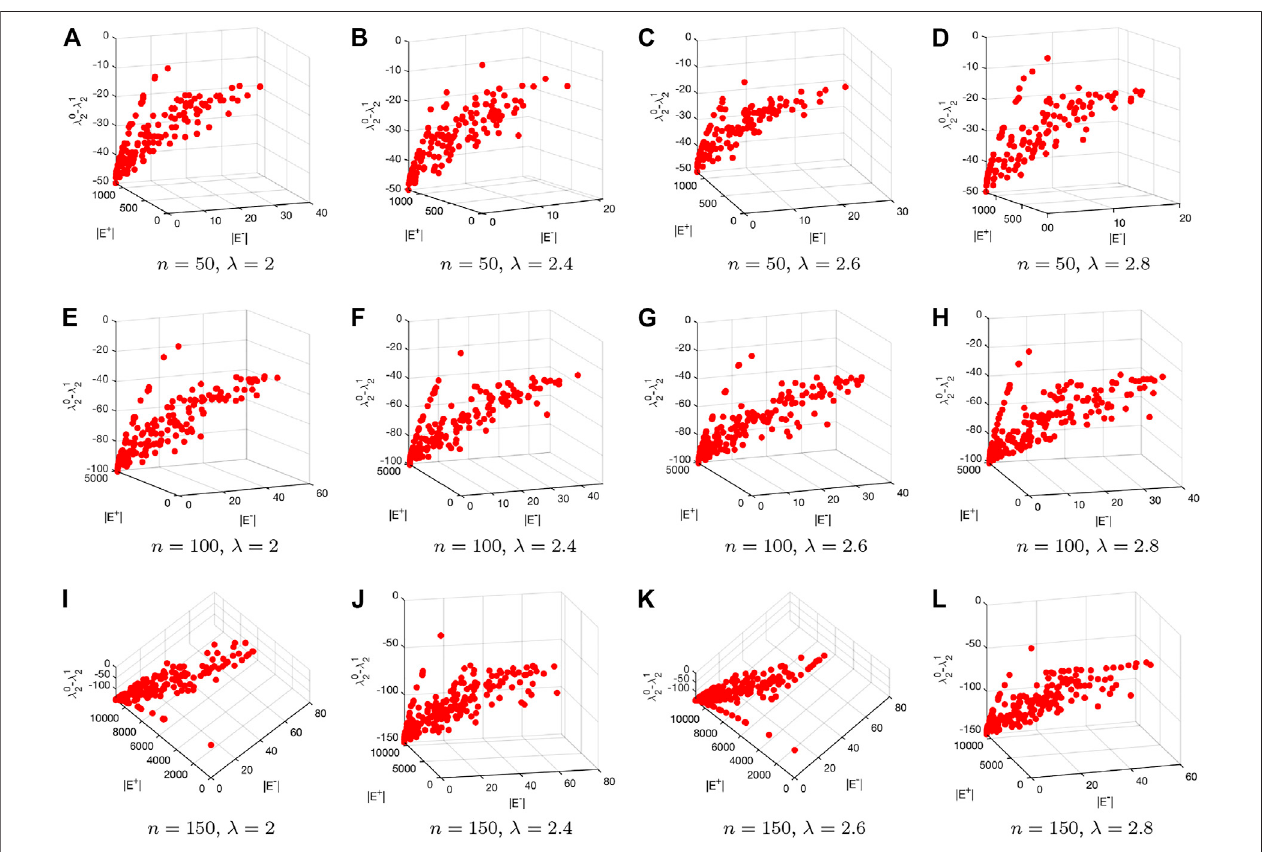
FIGURE 9 | Visualization of the Pareto fronts obtained by applying the introduced multiobjective particle swarm optimization algorithm to the generated scale-free networks.